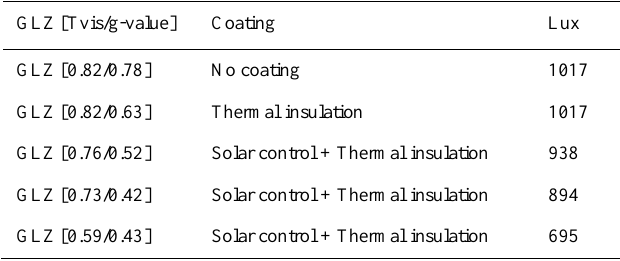
Table 2. Average annual illuminance at the reference point